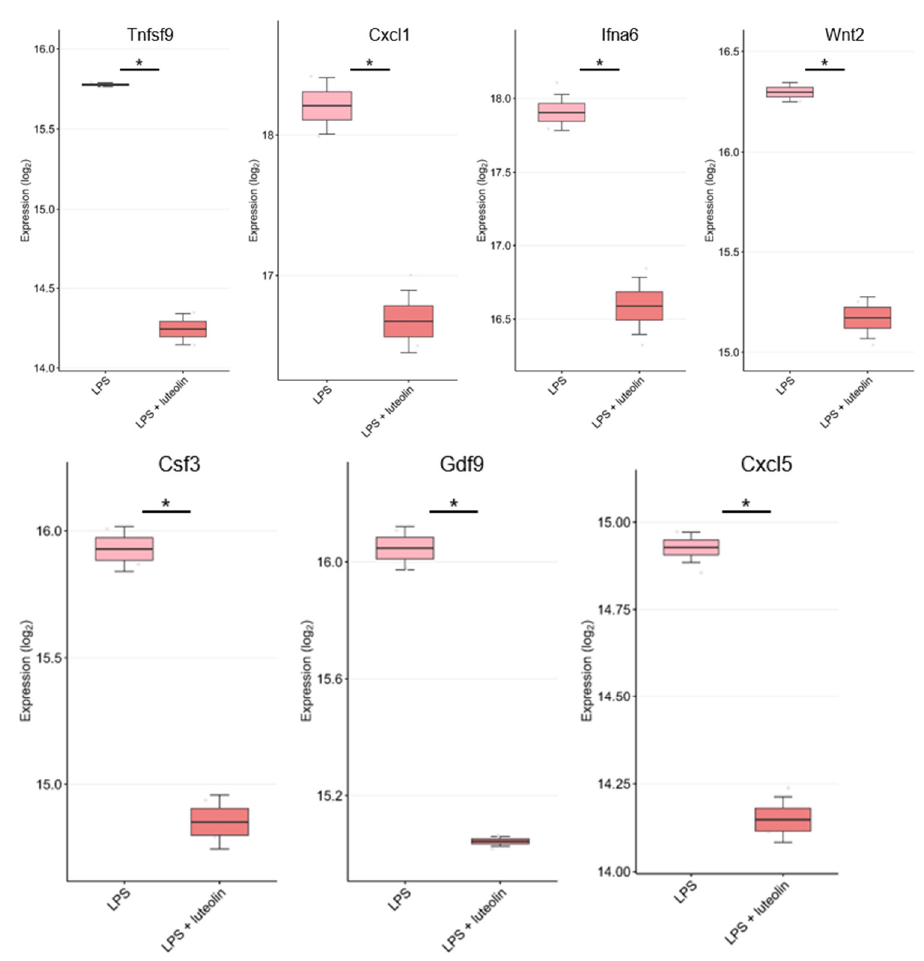
Figure 5. Comparison of Tnfsf9 , Cxcl1 , Ifna6 , Wnt2, Csf3, Gdf9, and Cxcl5 expression in mouse neural stem cells treated with LPS and with LPS and luteolin. The gene expression of each cytokine/chemokine was analyzed using the GSE181522 dataset. *: p < 0.05 compared to the induction group.